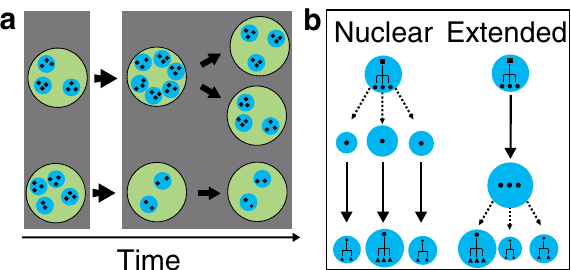
Fig. 1 Schematic of the model. a The multi-level evolutionary process. Societies (green) comprise families (blue) in which family members (black) live together. The grey frame represents a single generation. When the population of a society reaches twice the initial population, a society splits and another society is removed from the system at random to keep the number of societies fi xed — i.e. we adopt the hierarchical Moran process. b The life cycle of families. The black squares, circles, and triangles represent members of different generations. The size of the blue circle re fl ects the amount of wealth that each family possesses. The dashed arrows show the separation of siblings, and the arrows show the production of wealth through family labour. Each family has a strategy parameter s . With the probability of 1 − s , siblings are separated before production, and then they produce independently and reproduce the next generation, as in a nuclear family. On the other hand, with the probability of s , siblings produce together, after which they build their own home and reproduce the next generation, as in an extended family. When we extend the model to consider marriage, its process is added just before